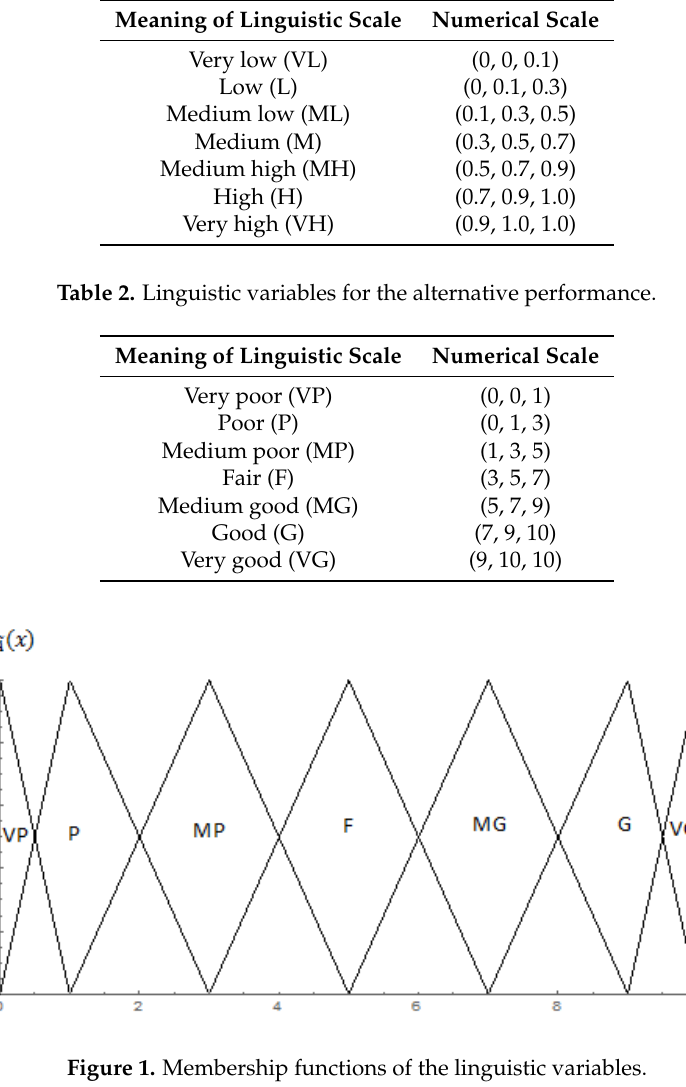
Figure 1. Membership functions of the linguistic